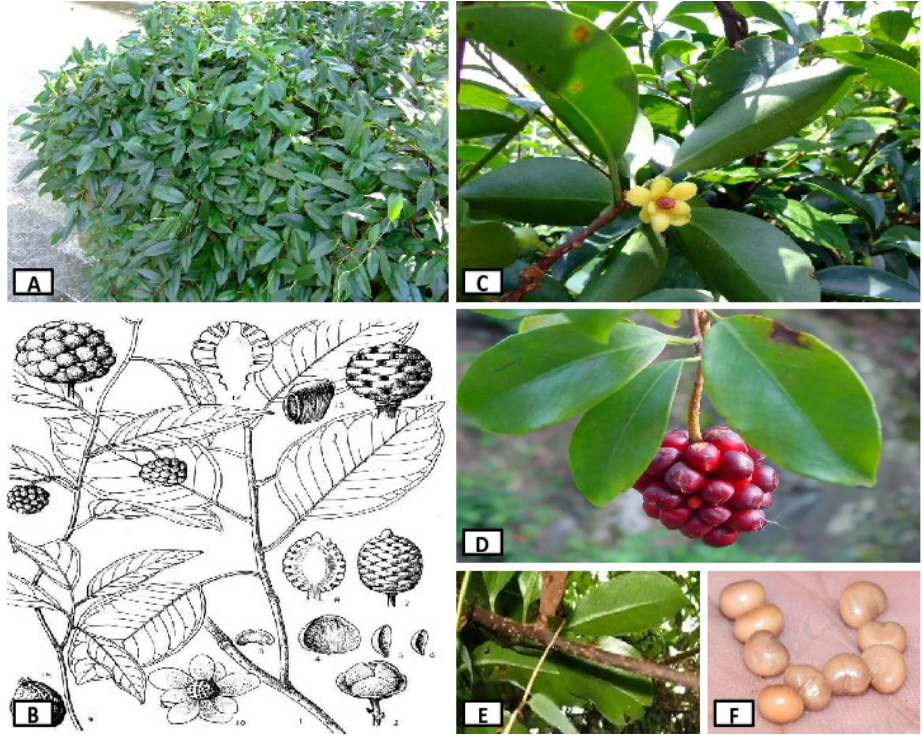
Figure 1. The entire K. longipenduculate plant ( A ), all plant characteristic ( B ), flower ( C ), fruit ( D ), stem ( E ), and seed ( F ).